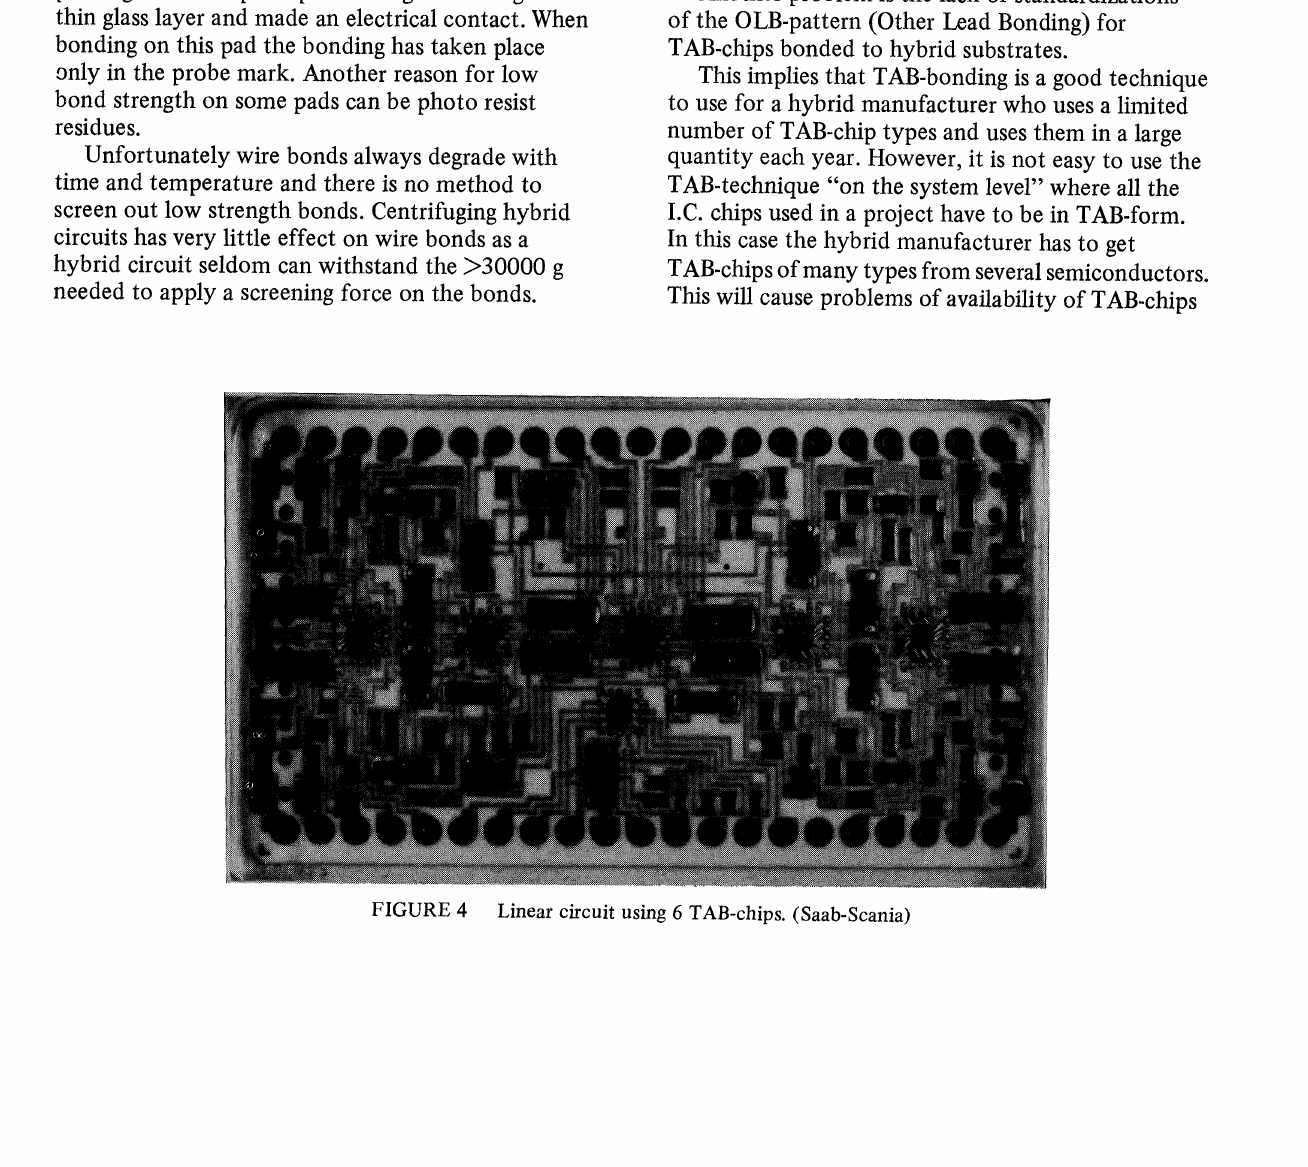
FIGURE 4 Linear circuit using 6 TAB-chips.